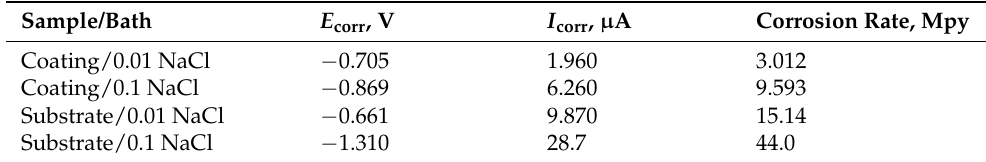
Figure 5. Potentiodynamic polarization curves for Al-BMG coatings and Al-6061 substrate in ( a ) 0.01 and ( b ) 0.1 N NaCl electrolyte. Reprinted with permission from [53] Copyright 2021 Elsevier. Table 2. Corrosion behavior of Al-BMG coating and Al-6061 substrate at different concentrates of NaCl bath [53].